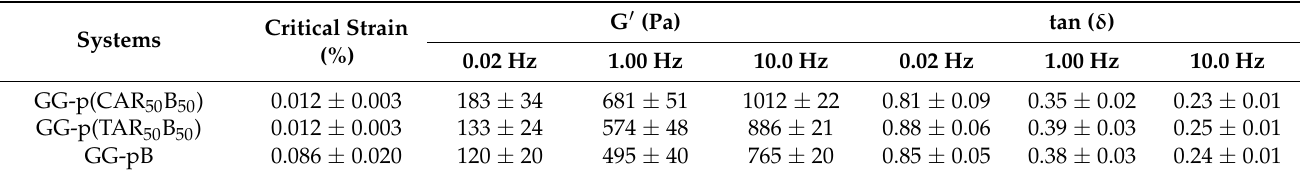
Table 5. Critical strain, elastic modulus (G (cid:48) ), and tan ( δ ) values at 0.02, 1.00, and 10.0 Hz for the different systems